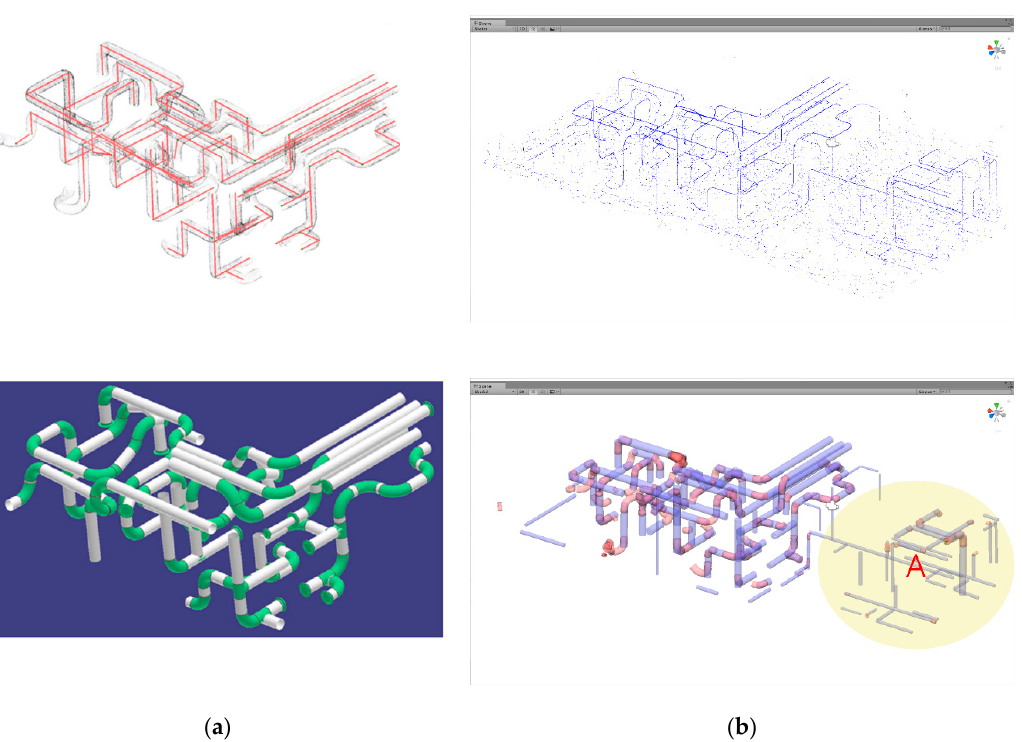
Figure 13. Comparison of proposed method with actual data (left side of Figure 12b). From top to bottom: point cloud/cylinder matching/center axis/final result. ( a ) Estimation by Hough transform[10]; ( b ) estimation by proposed method.